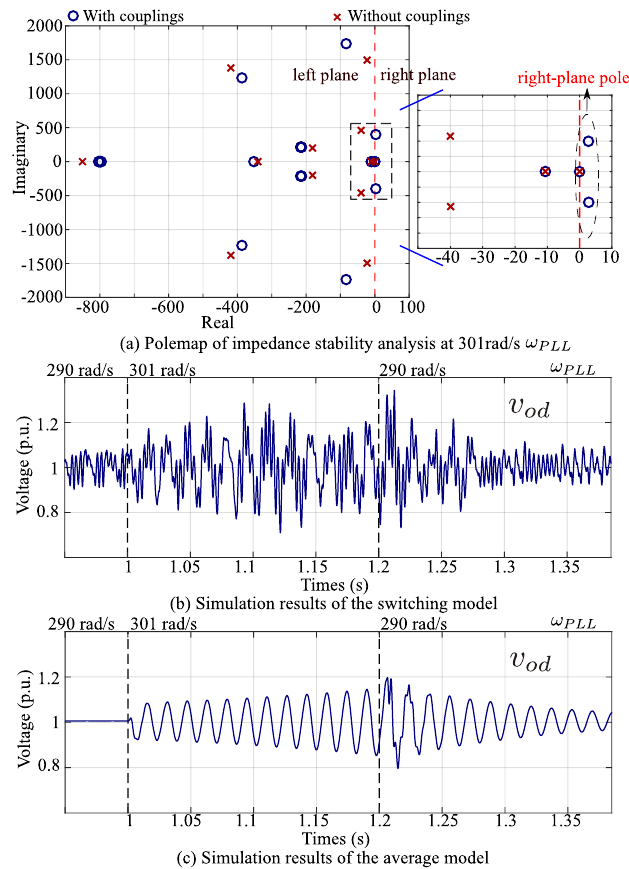
Figure 4. Time-domain simulation to validate the impedance stability analysis subject